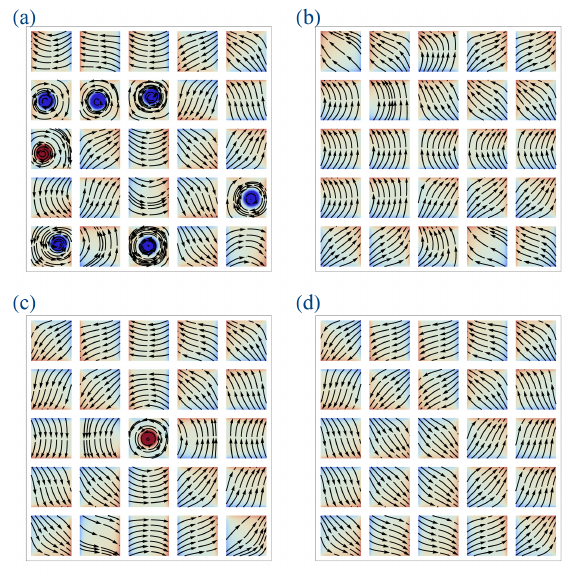
Figure 3. Equilibrium magnetization configurations result- ing from various initial magnetization configurations. (a) ran- dom configuration, (b) uniform magnetization oriented along a platelet side (y-axis) and centered (c) and o ff -centered (d) ortho- radial magnetization configurations. The geometrical parameters are: L = 90 nm, L z = 12 nm and δ = 15 nm. The color code and the arrows meaning are the same as in Fig.